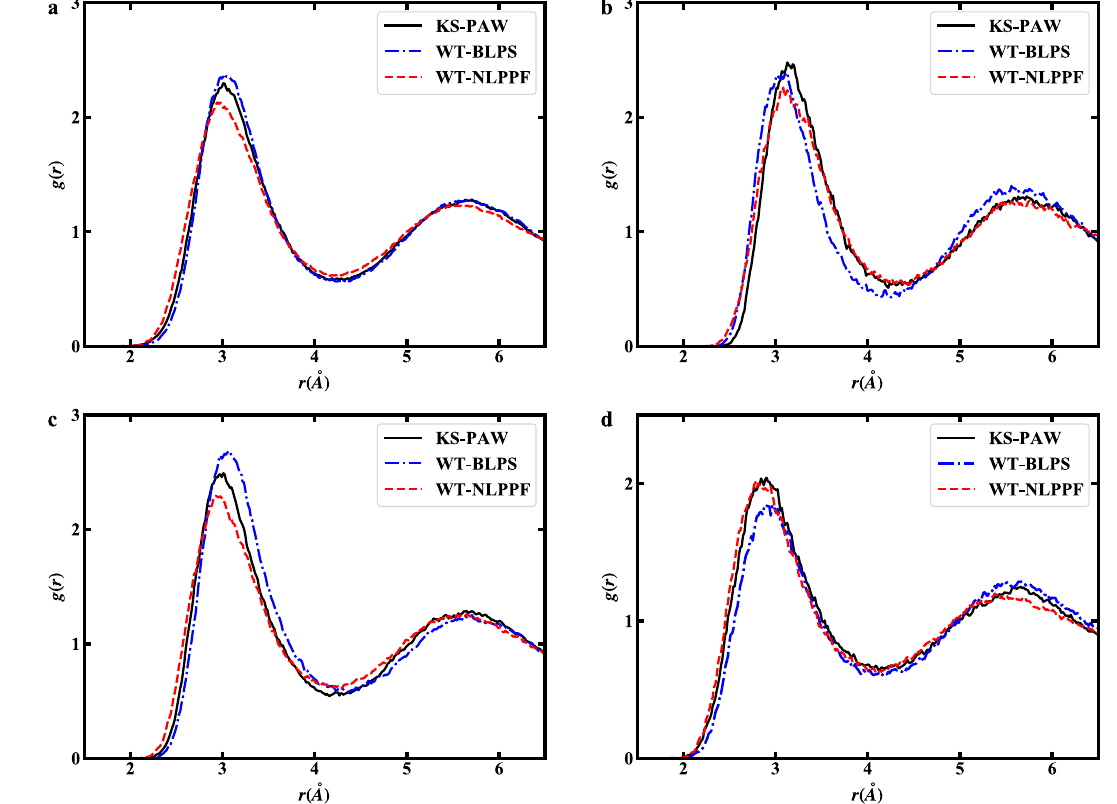
Fig. 1 Pair distribution functions for Li 54 Mg 54 alloy. a Total, b Mg-Mg, c Li-Mg, and d Li-Li pair distribution